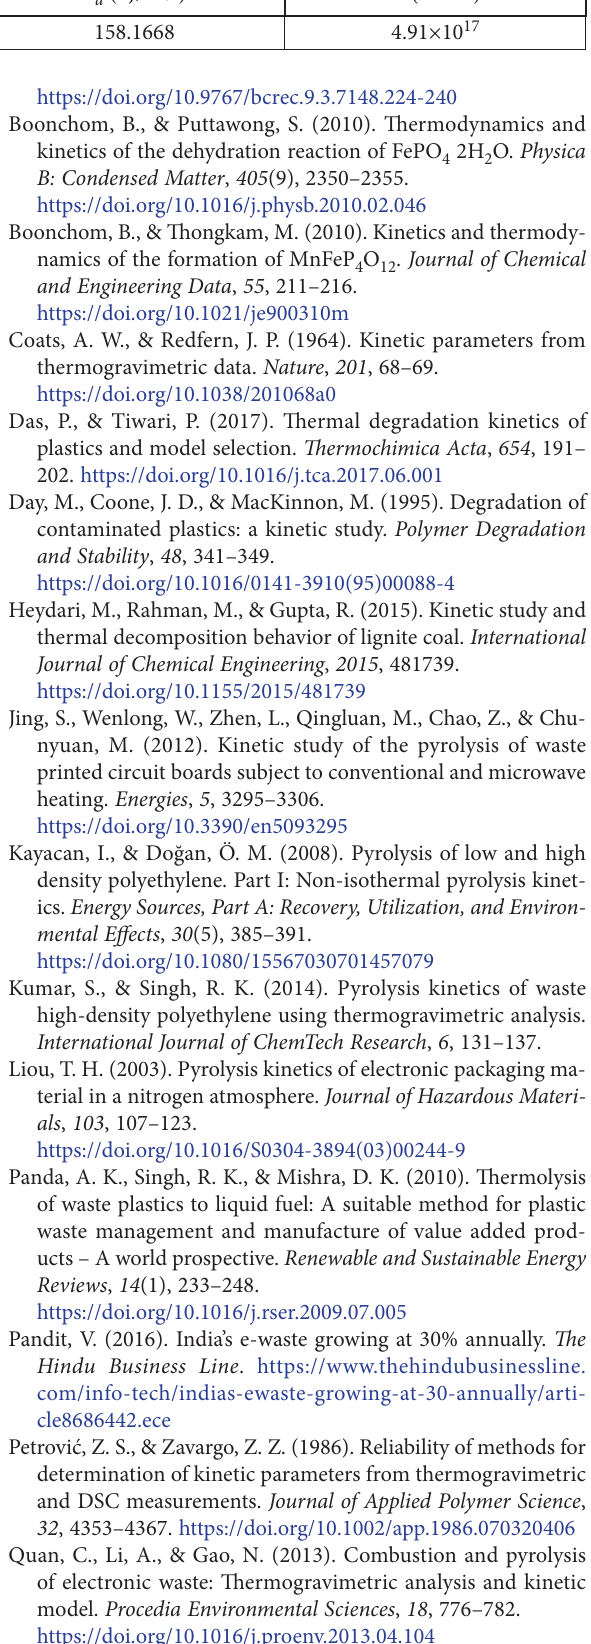
Table 4. Value of activation energy ( E a ) and pre-exponential factor ( A ) using Kissinger method at a single heating rate Fitted equation R